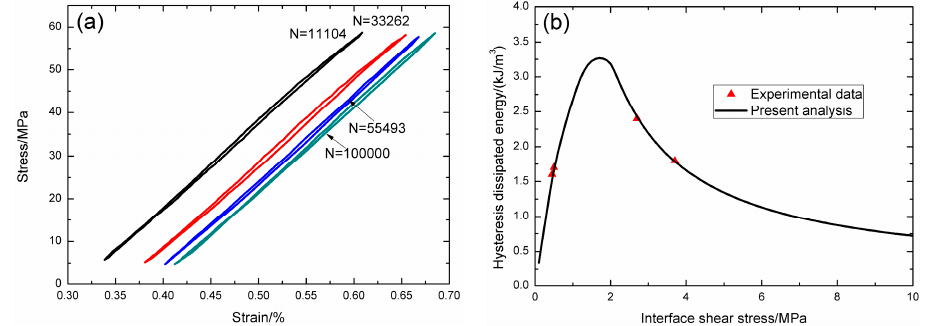
Figure 9. ( a ) The experimental fatigue hysteresis loops corresponding to different cycle number; and ( b ) the experimental and theoretical fatigue hysteresis dissipated energy versus interface shear stress curve of 2D woven C/SiC composite under σ max = 57 MPa at room temperature. Table 4. The interface shear stress of 2D woven C/SiC composite corresponding to different applied cycles under fatigue peak stress of σ max = 57 MPa at room temperature. Experimental Hysteresis Cycle Number Dissipated Energy/(kJ/m 3 )